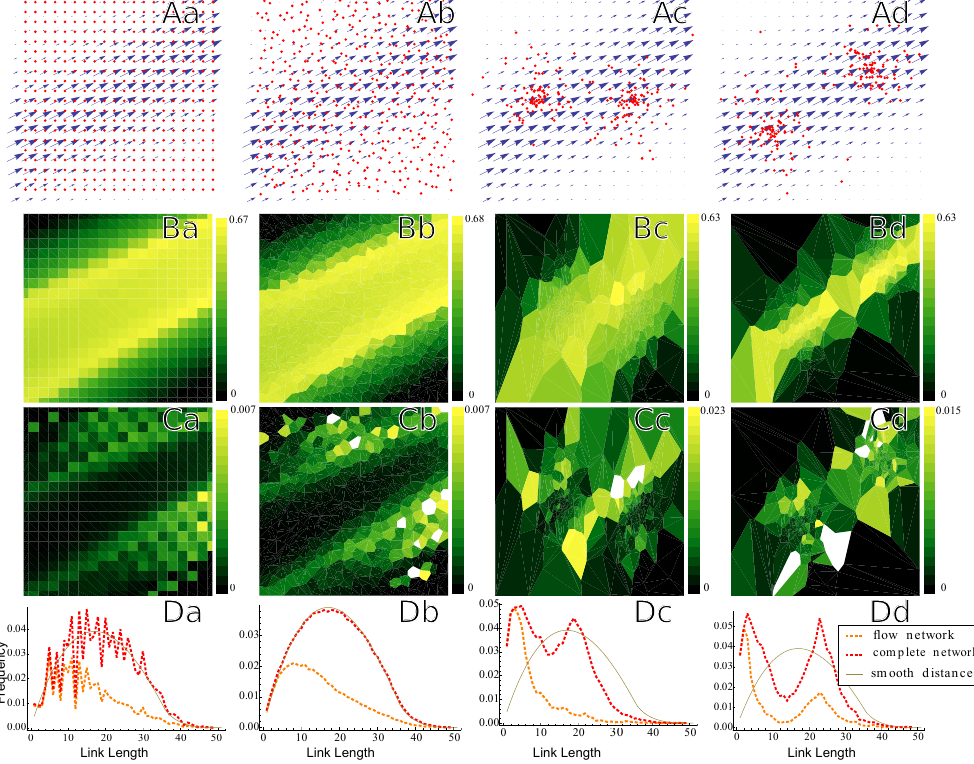
Figure 1. A diagonal flow is sampled with (Aa) a grid, (Ab) a jittered grid, (Ac) two clusters on opposite sides of the flow, and (Ad) two clusters inside the flow. The networks are constructed with a link density of 40%. Row (B) shows the degree, row (C) the betweenness and row (D) the link length